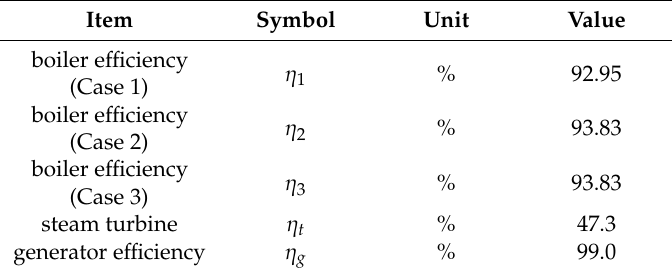
Table 1. Detailed operation